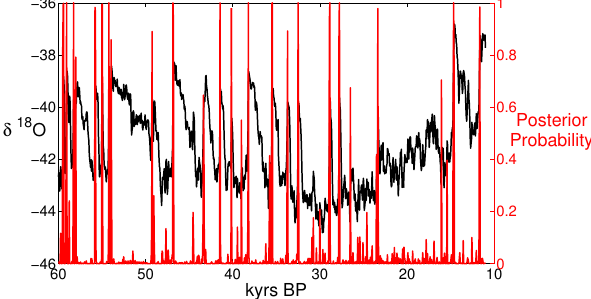
Fig. 4: Posterior probability of DO event as a function of time for NGRIP on the GICC05 timescale.